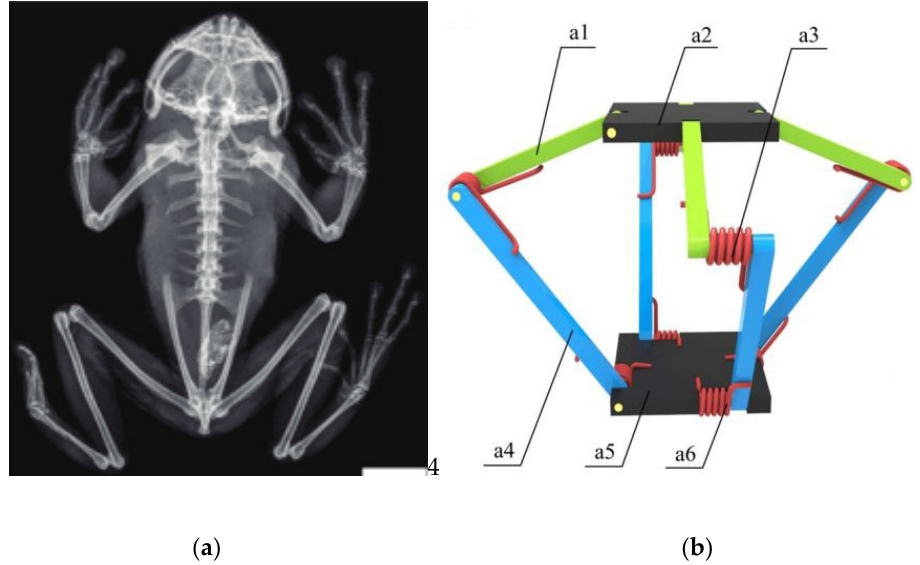
Figure 12. ( a ) Limb structure of a frog [59], ( b ) bionic QZS device: a1, the rods in the second layer; a2, the supporting plate; a3, the torsion springs in the second layer; a4, the rods in the first layer; a5, the bottom plate; a6, the torsion springs in the first layer [60].